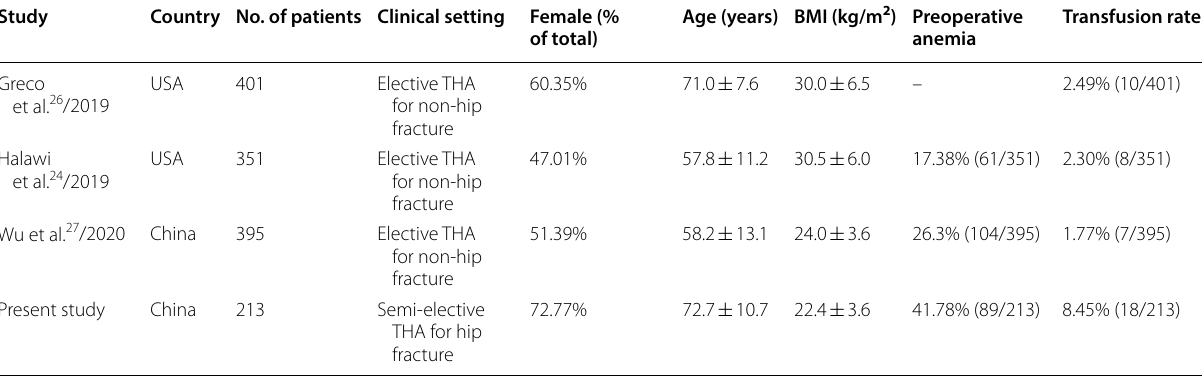
BMI body mass index, THA total hip